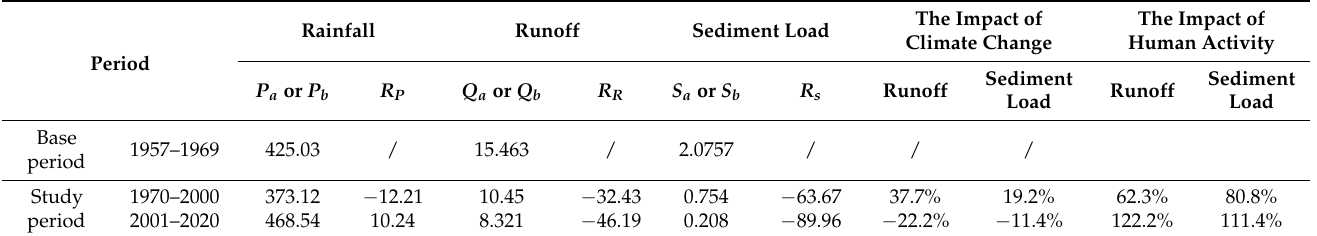
Table 3. Contribution rate of climate change and human activities in the Wuding River basin during the study period calculated by the cumulative curve method.